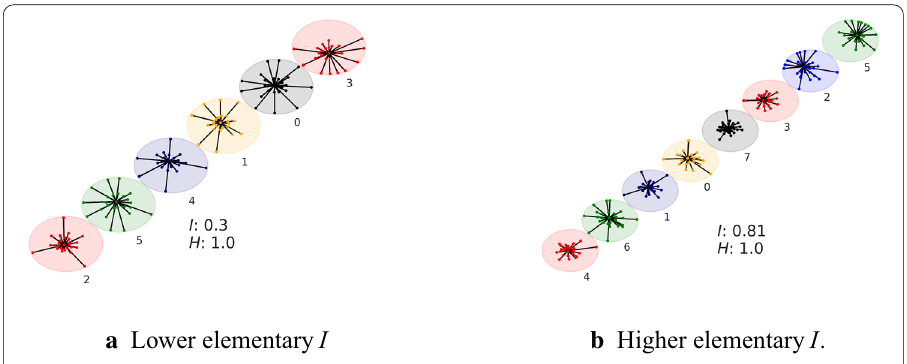
Fig. 6 Visualization of inner-layer edges in synthetic coupled multilayer